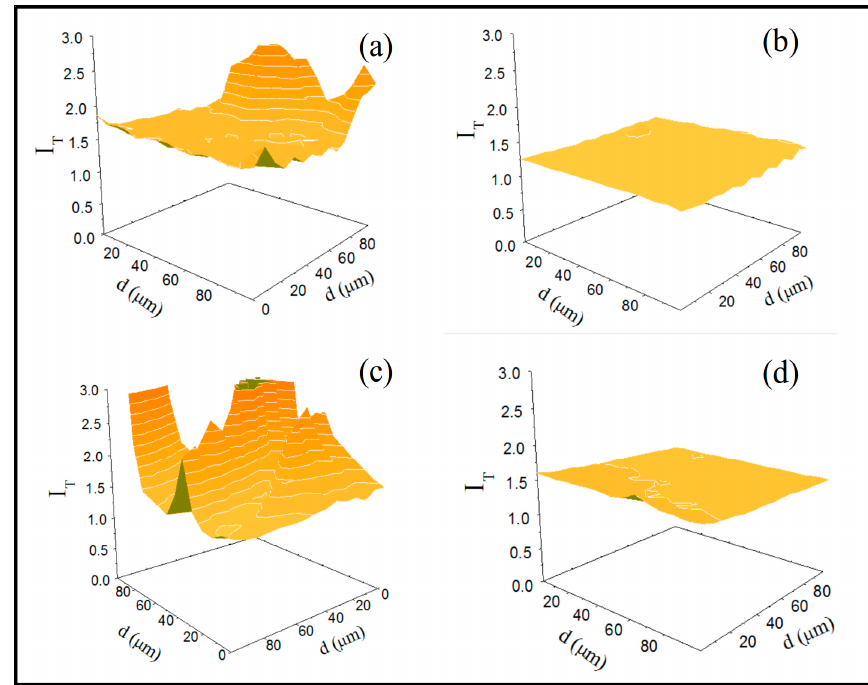
Figure 3. Scanning Electrochemical Microscopy, SECM surface-plot images of ( a ) GCE/CRGO; ( b ) GCE/hTRGO; ( c ) GCE/ERGO; and ( d ) GCE/TRGO. Experimental conditions: 5.0 × 10 − 4 M FcOH, supporting electrolyte: 0.10 M phosphate buffer solution with a pH of 7.00, ET = 0.050 V, ES = 0.000 V, UME scan rate: 10 µm·s − 1 .